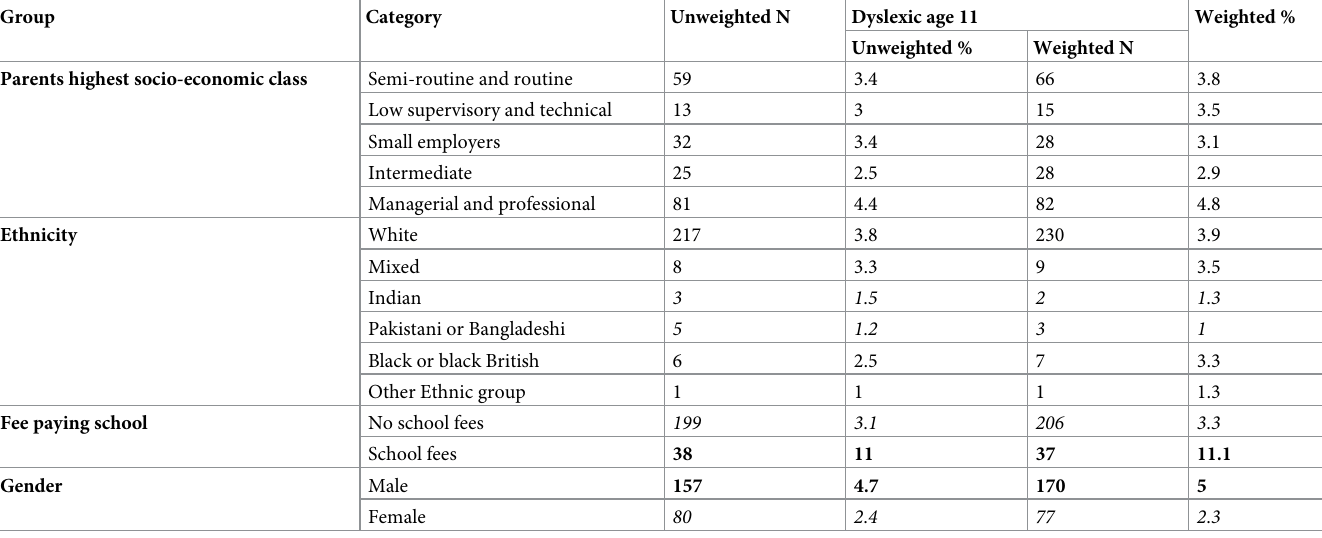
Table 2. Bivariate analysis of dyslexia and categorical characteristics.